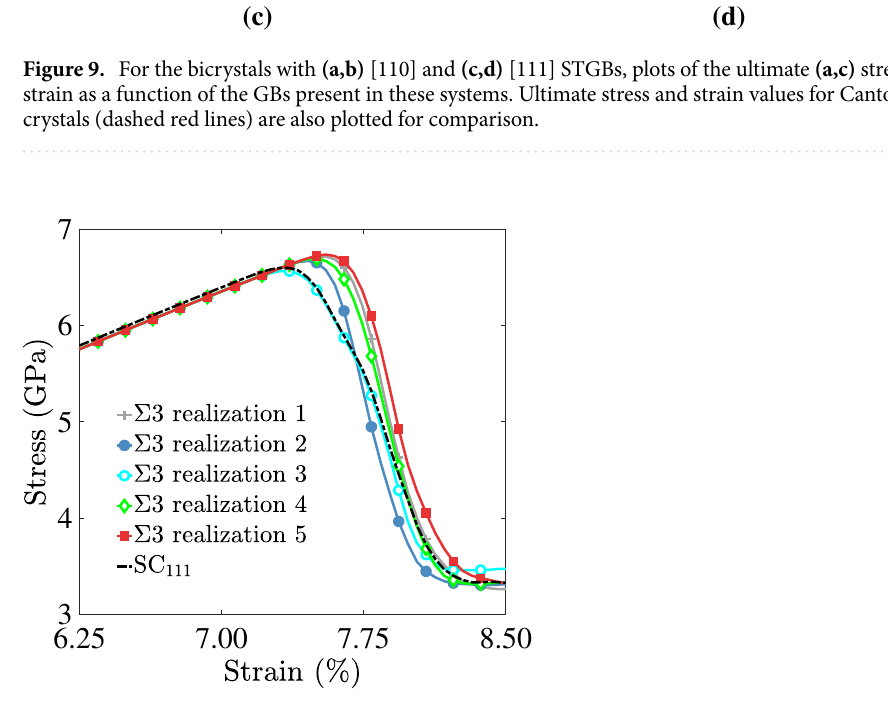
Figure 10. A close-up view of the stress-strain curve for several realizations of the bicrystal system with a (cid:31) 3 [111] STGB, demonstrating the effect of local GB chemistry. The curve for the single crystal system ( SC 111 ) is also